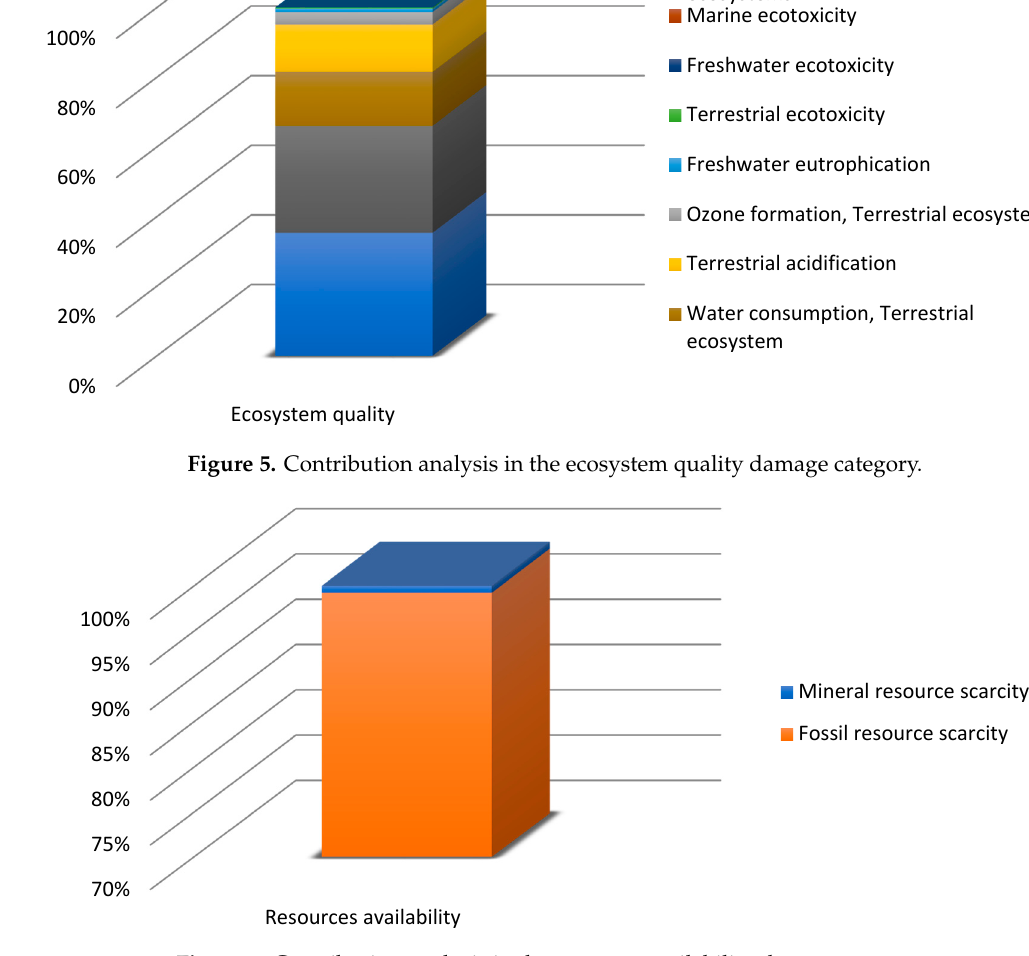
Figure 6. Contribution analysis in the resource availability damage category.